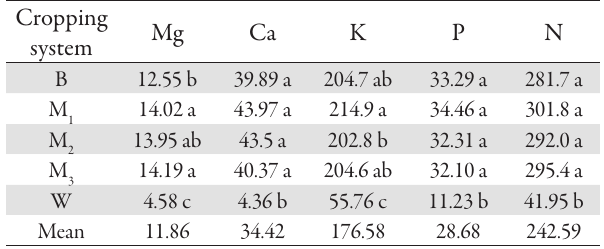
Tab. 5. Effect of different cropping system on intercrop competition for